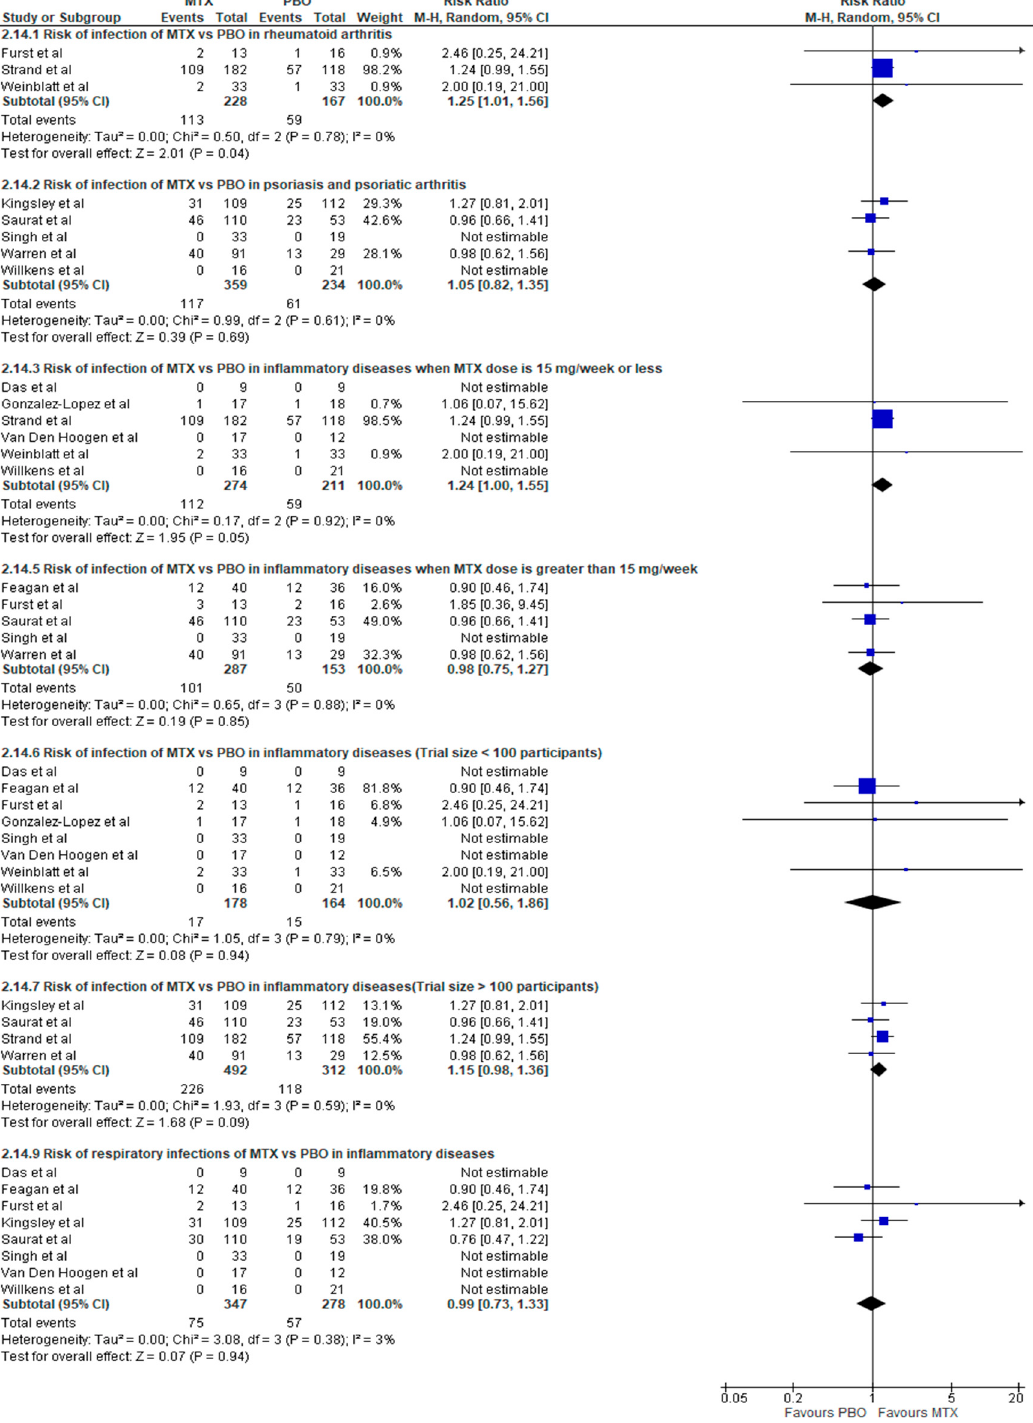
Figure 4. Forest plot: Subgroup analyses in risk of infection with methotrexate therapy in inflammatory diseases (Studies included: [27–31,33–39]).